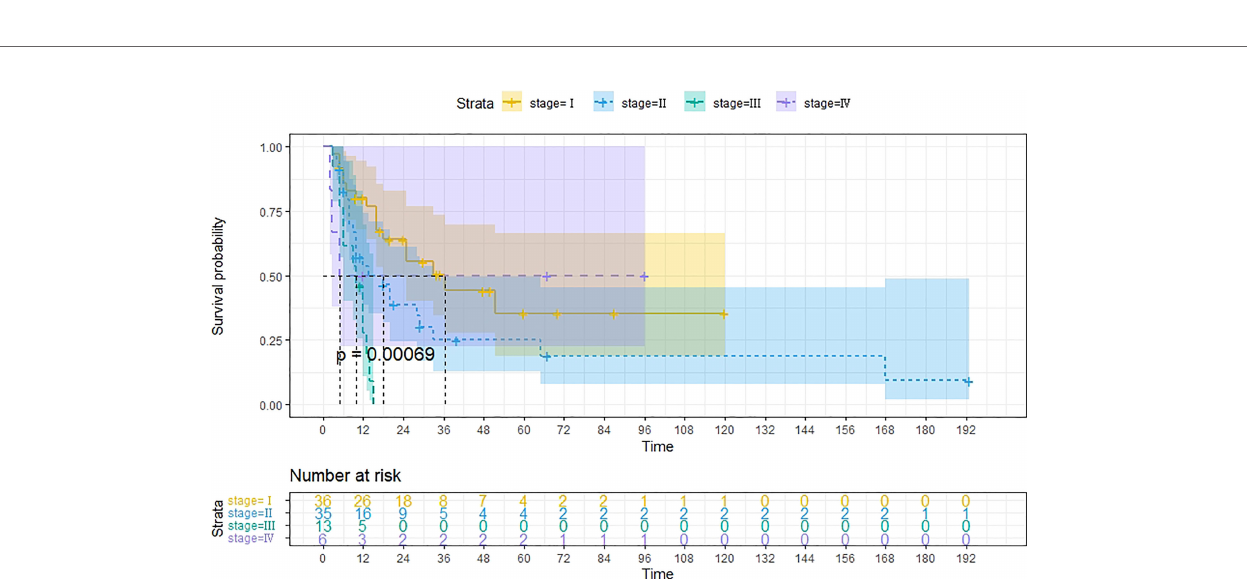
FIGURE 3 | Kaplan-Meier survival curves for OS in patients of different FIGO stage. The median OS for FIGO I, II, III, IV are 36m, 18m, 10m, 5m